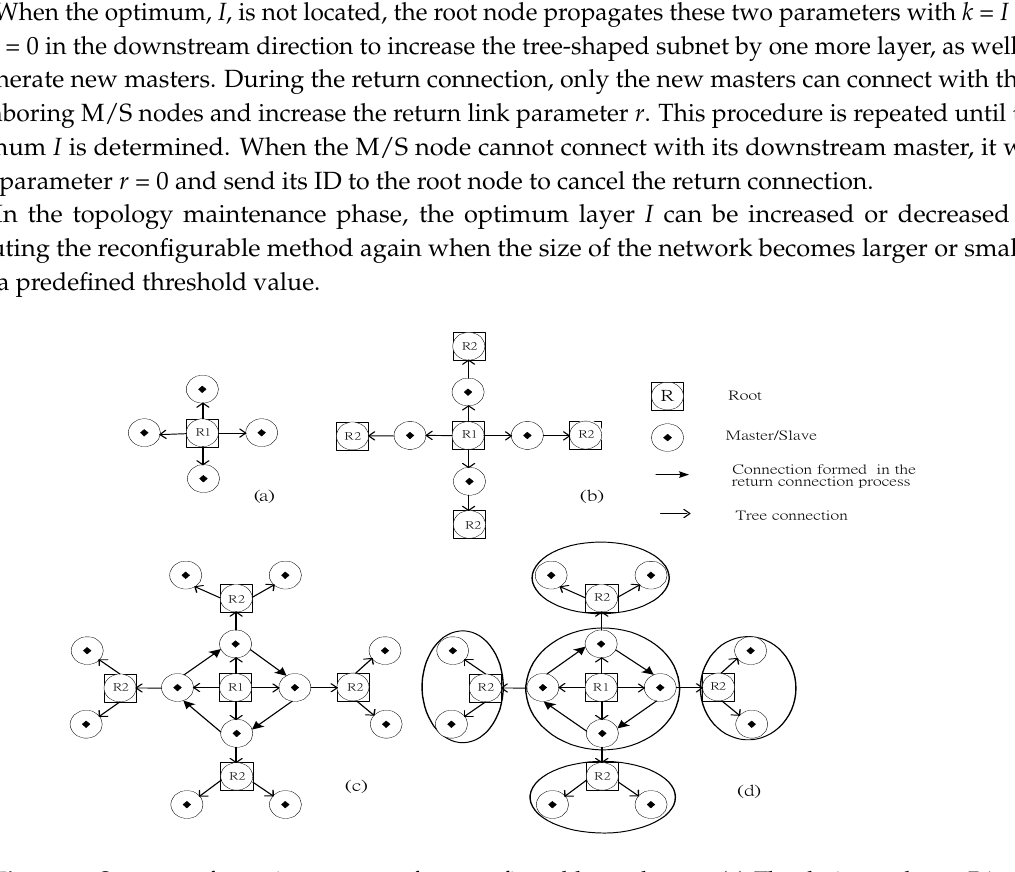
Figure 1. Scatternet formation process of a reconfigurable mesh-tree. ( a ) The designated root R1 connects with the first tier masters. ( b ) When the second tier masters R2 are reached and the counter limit k = 0, these masters become new roots. ( c ) These new roots request their upstream masters to start the return connection procedure until R1 is reached. ( d ) The mesh-shaped topology of the designated root is formed and each new root manages its own tree-shaped subnet. R1, the designated root; R2, the second tier masters.